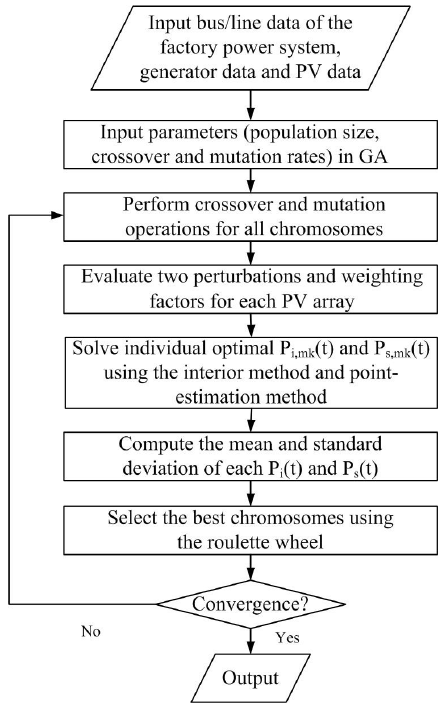
Figure 9. Flowchart of the proposed method.